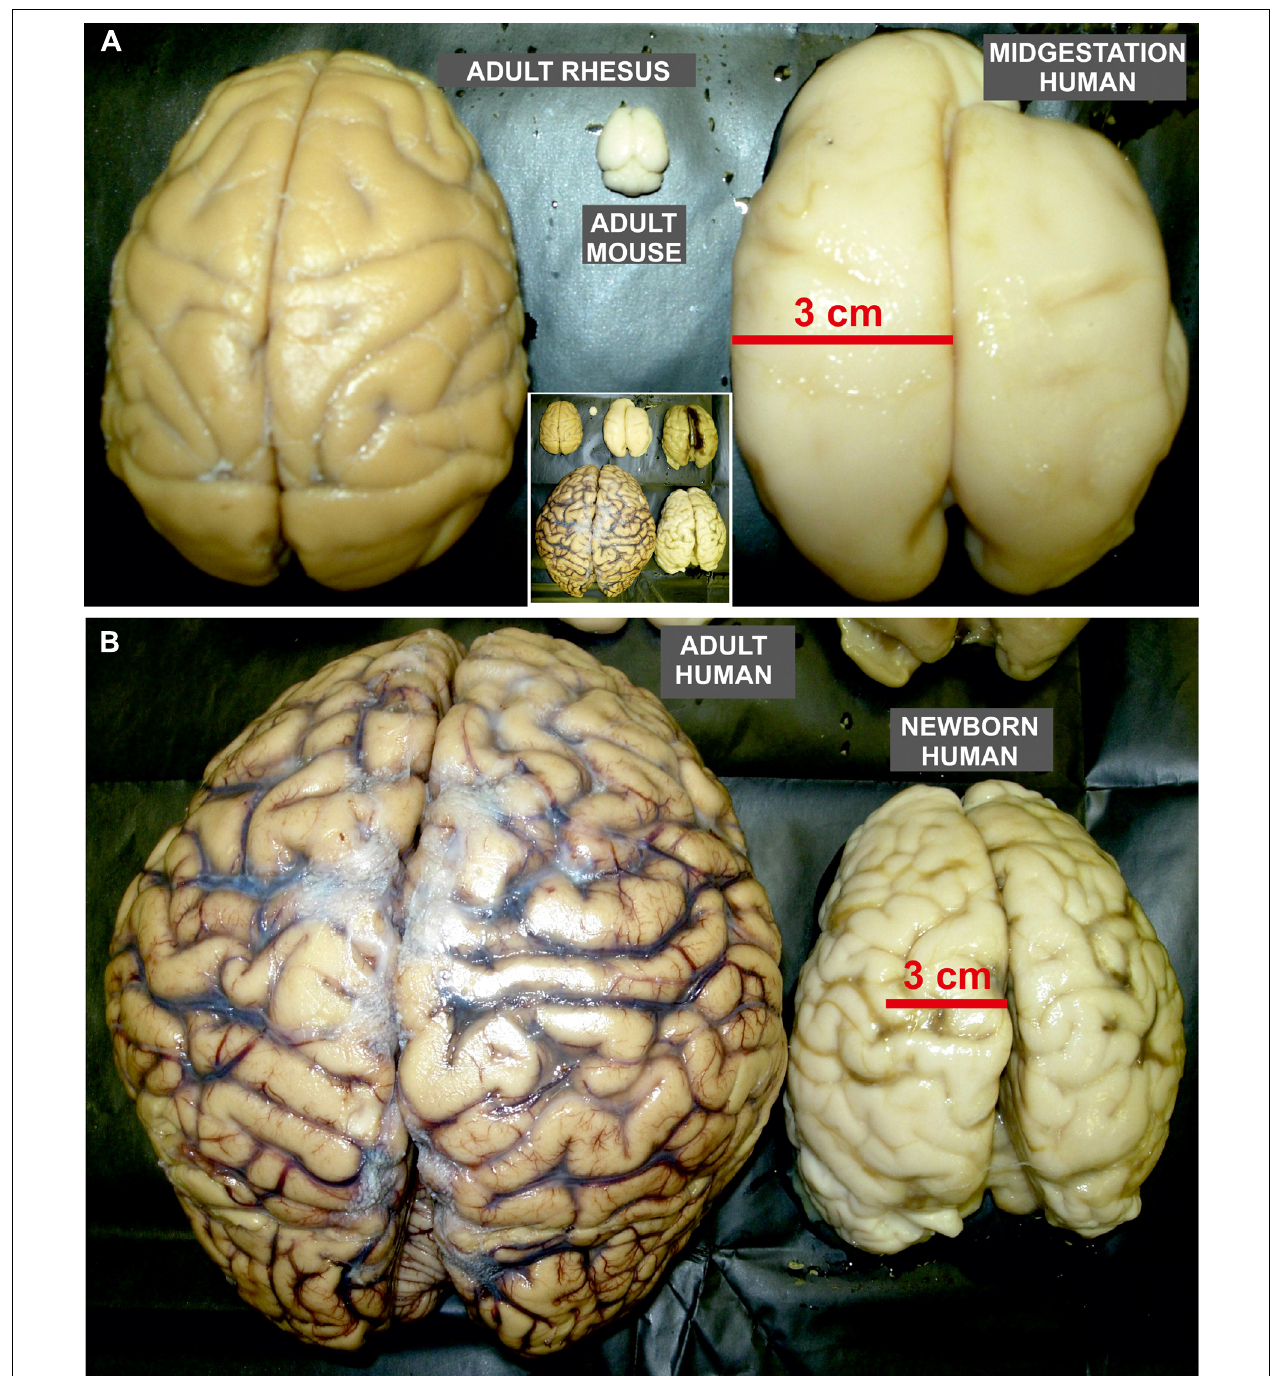
around 3–4 times larger than newborn brain which size reaches the size of adult chimpanzee brain. Note that the pattern of gyrification in human newborn brain is close to the one observed in adult. The inlet in the middle of the figure is the integrative photo of all brains shown in A and B that demonstrate their actual proportions (the right brain in the upper row of insertion is from fetus at the beginning of third trimester of